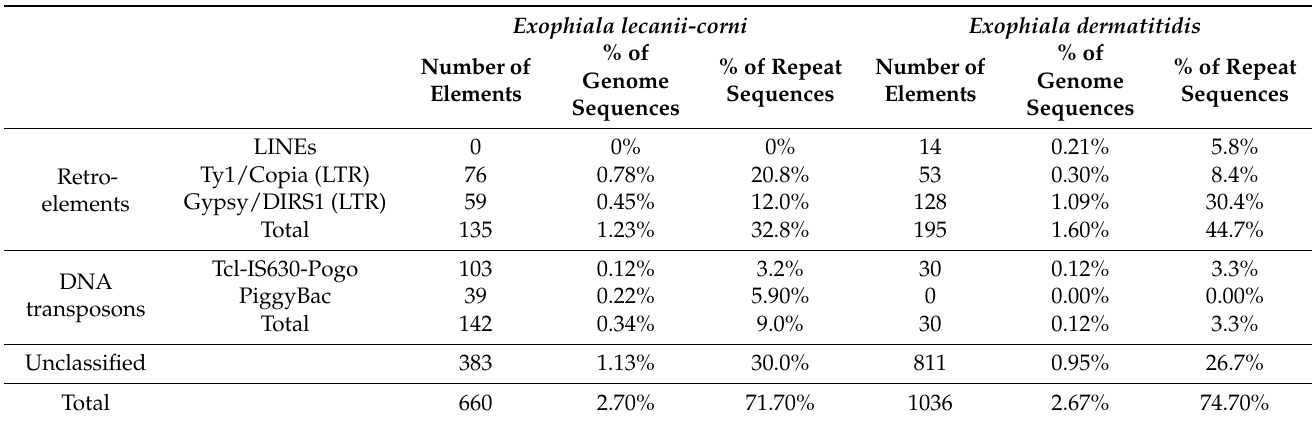
Table 2. Distribution of classified repeat elements within the genomes of E. lecanii-corni and E. dermatitidis